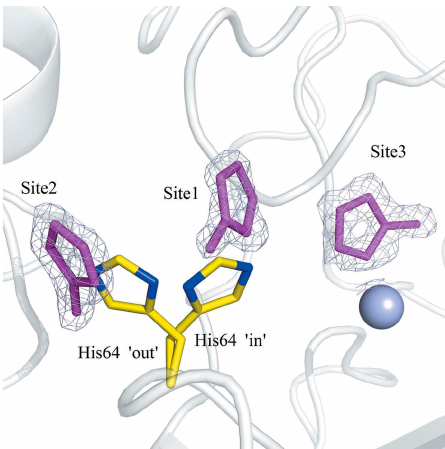
Figure 4. Binding sites (sites 1–3) of 4-methylimidazole (4MI) within and near the active site of His64A hCA II. The 2Fo Fc electron-density maps are contoured at 1.2 σ . His64 from wild-type CA II (PDB entry 3ks3 [23]) is shown as yellow sticks to represent the ‘in’ and ‘out’ conformations [22].